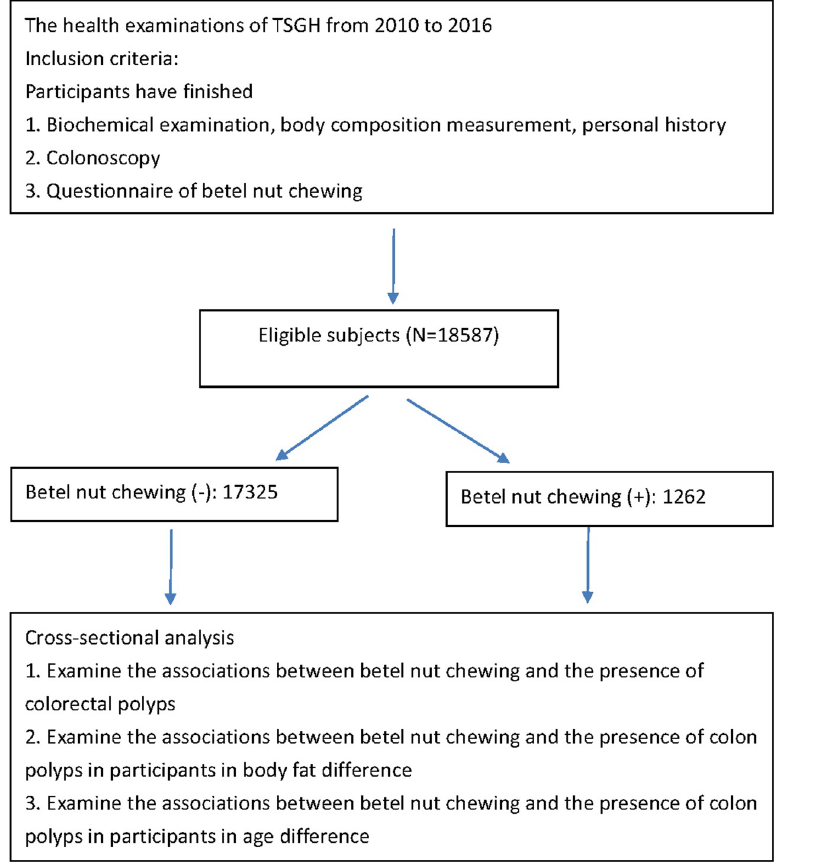
Fig 1. Flow chart which represented the steps of analysis performed in the